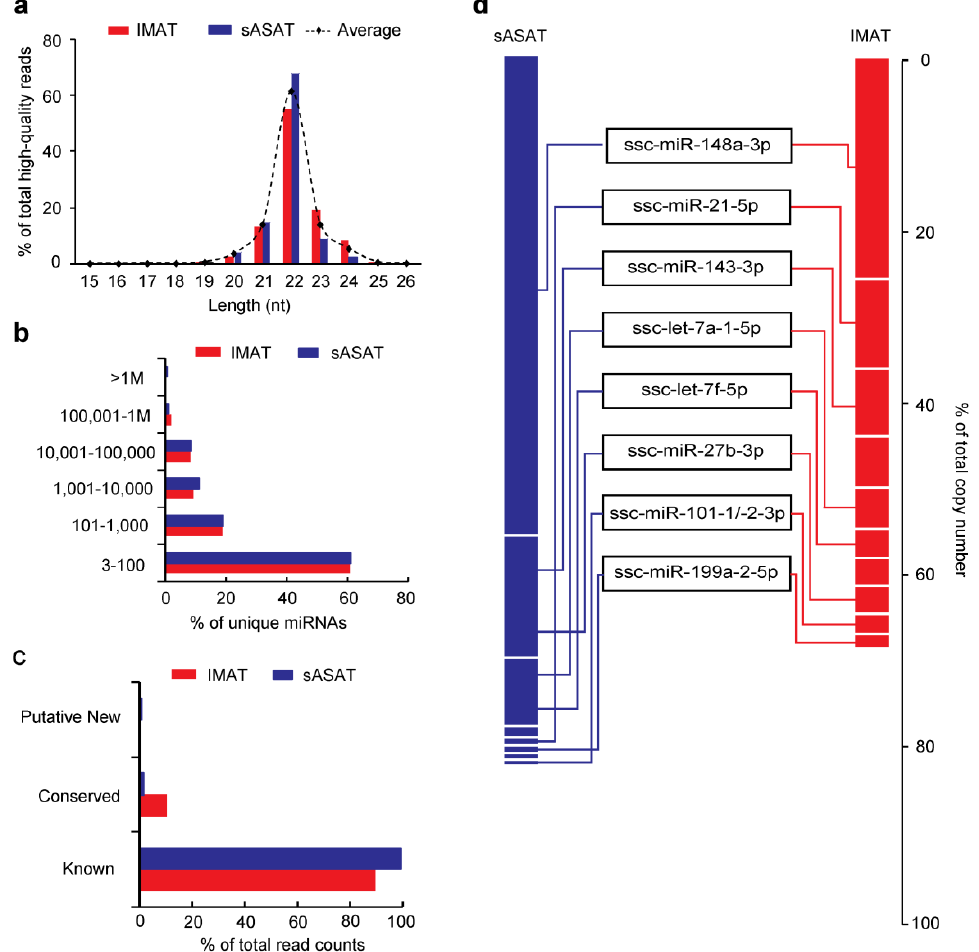
Figure 1. Description of miRNAs in two adipose tissues. ( a ) Length distribution of the high-quality reads; ( b ) Distribution of read counts of the identified miRNAs; ( c ) Distribution of read counts in the three defined miRNA groups; ( d ) Copy numbers of the top 10 miRNAs with highest read counts. IMAT, intermuscular adipose tissue; sASAT, superficial abdominal subcutaneous adipose